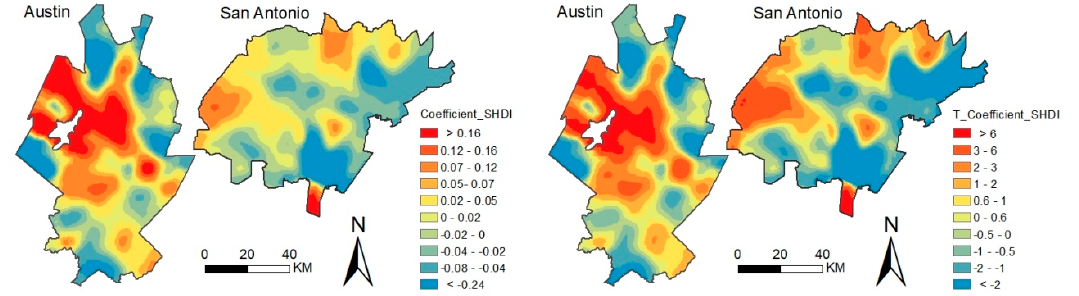
Figure 6. Overall spatial variation of the coefficients ( left ) and the t statistics ( right ): Shannon's Diversity Index (SHDI).